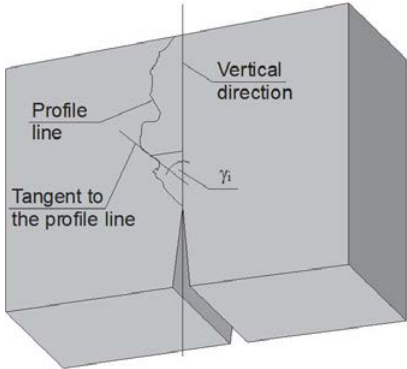
Figure 3. A scheme for the determination of angles identifying the direction of fracture development direction.